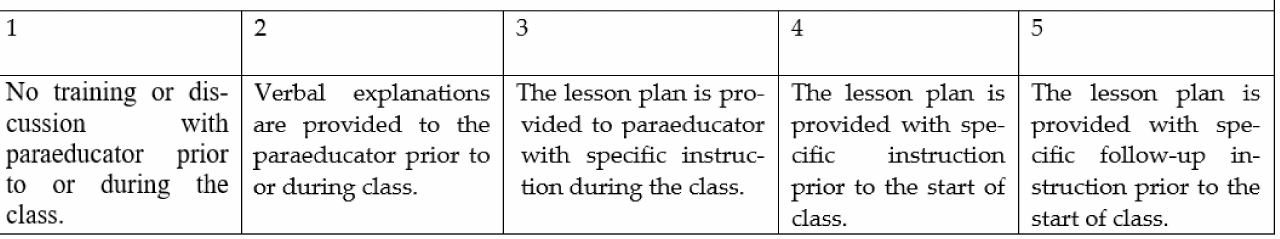
Figure 2. Original LIRSPE item and rubric 11